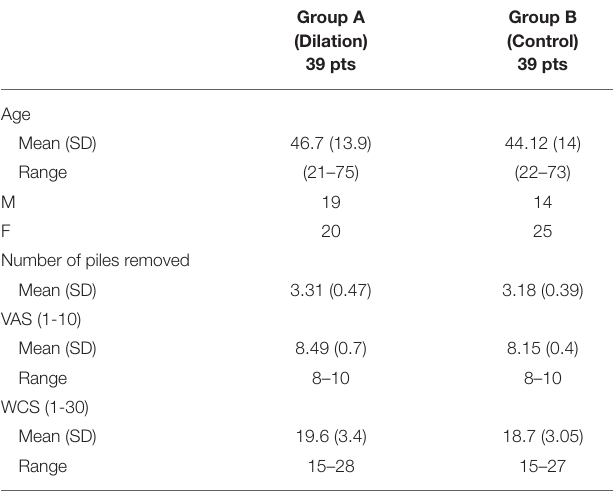
TABLE 1 | Demographic and clinical characteristics at